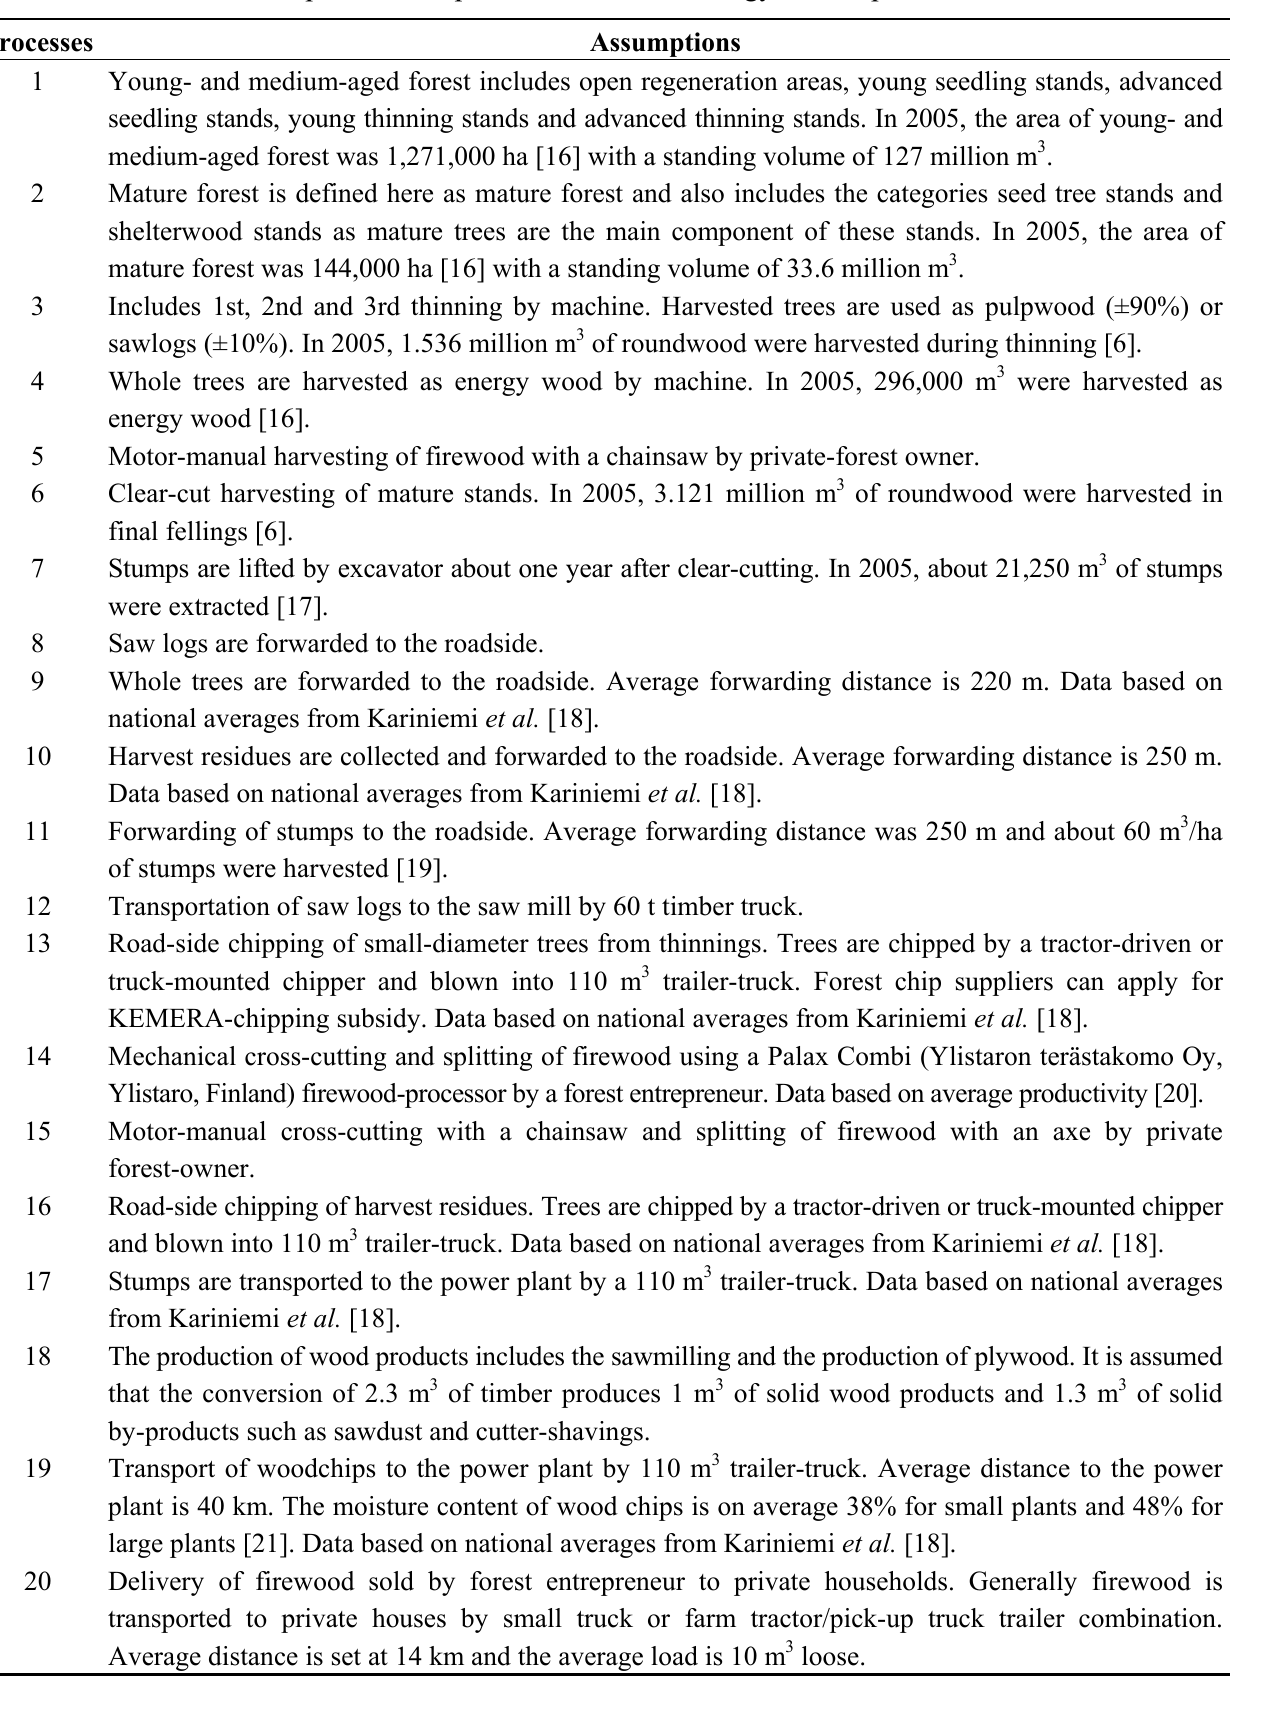
Table 1. Assumption for all processes of the bioenergy and oil production chains.